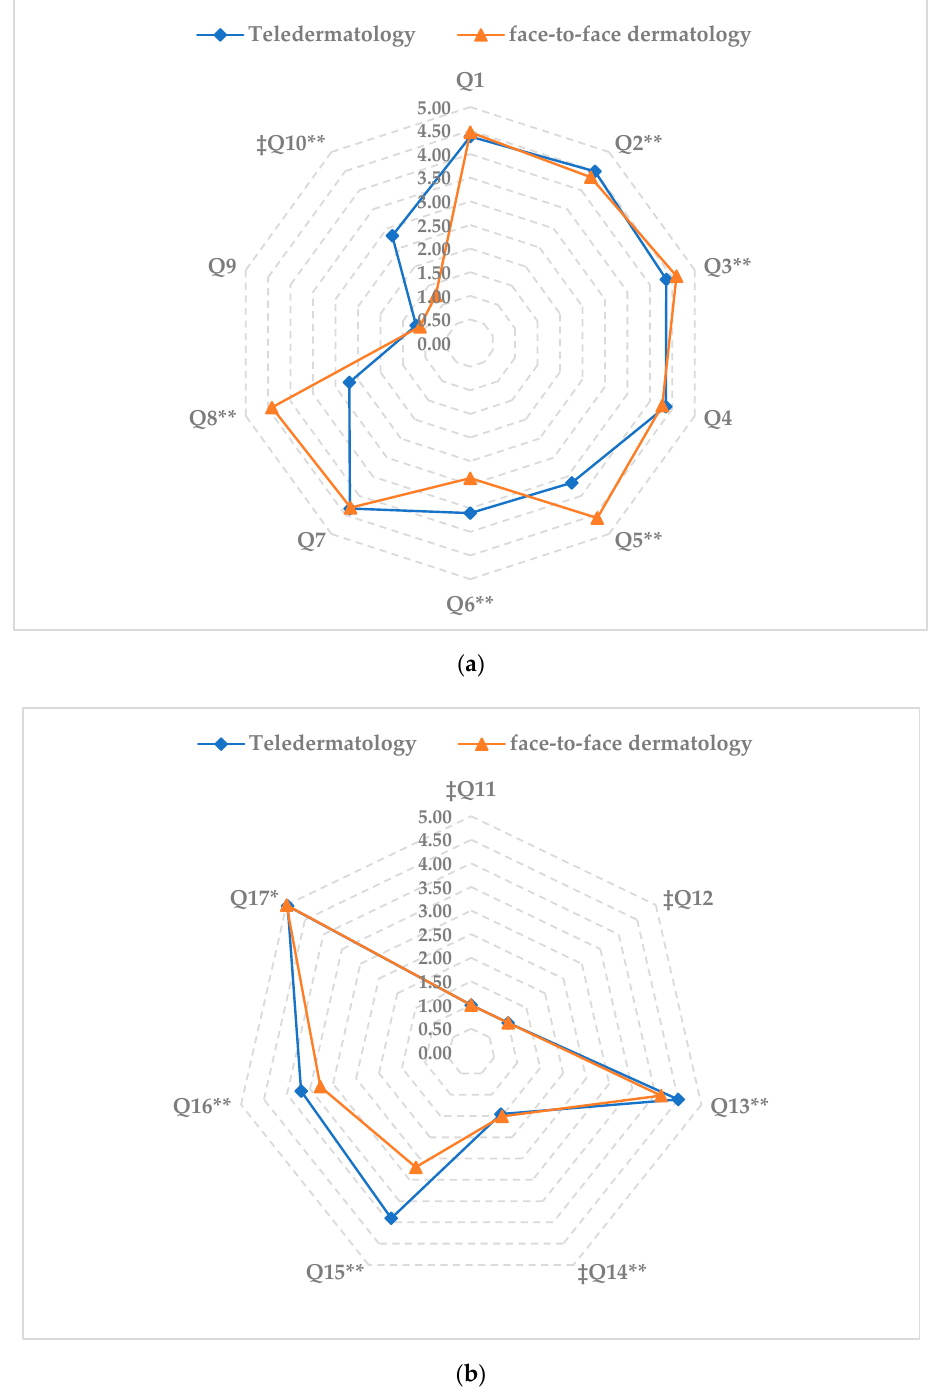
Figure 2. Results derived from patient experiences and communication questionnaire. ( a ) Patient experiences items; ** p < 0.01; ‡ negative items; see Table 1 for the content of the items. ( b ) Communication items; ** p < 0.01, * p < 0.05; ‡ negative items; see Table 1 for the content of the items.